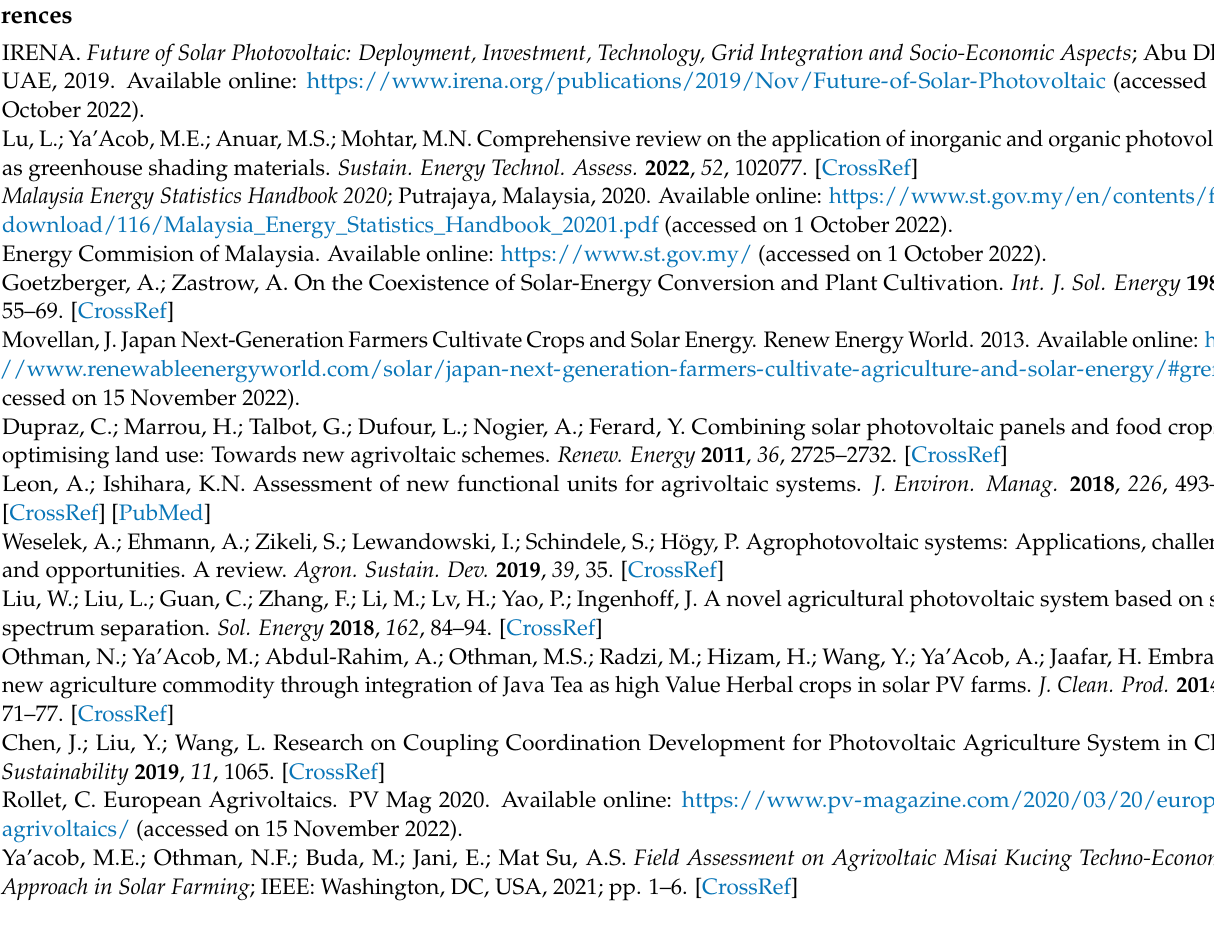
Figure A10. Grass Poaceae: Brachiaria mutica.